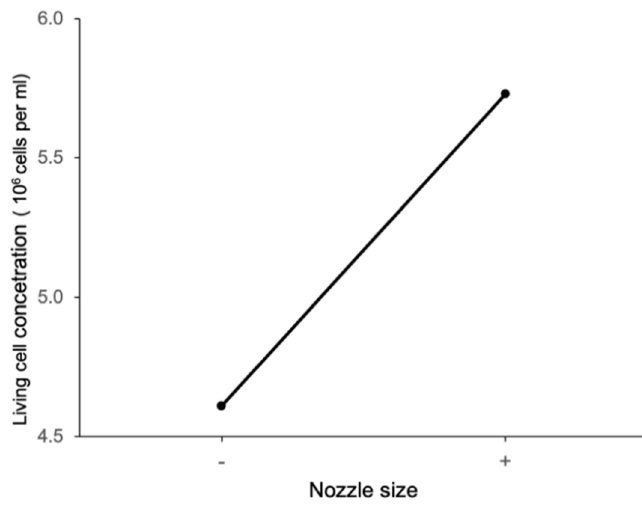
Figure 12. Main effect of nozzle size on living cell concentration.